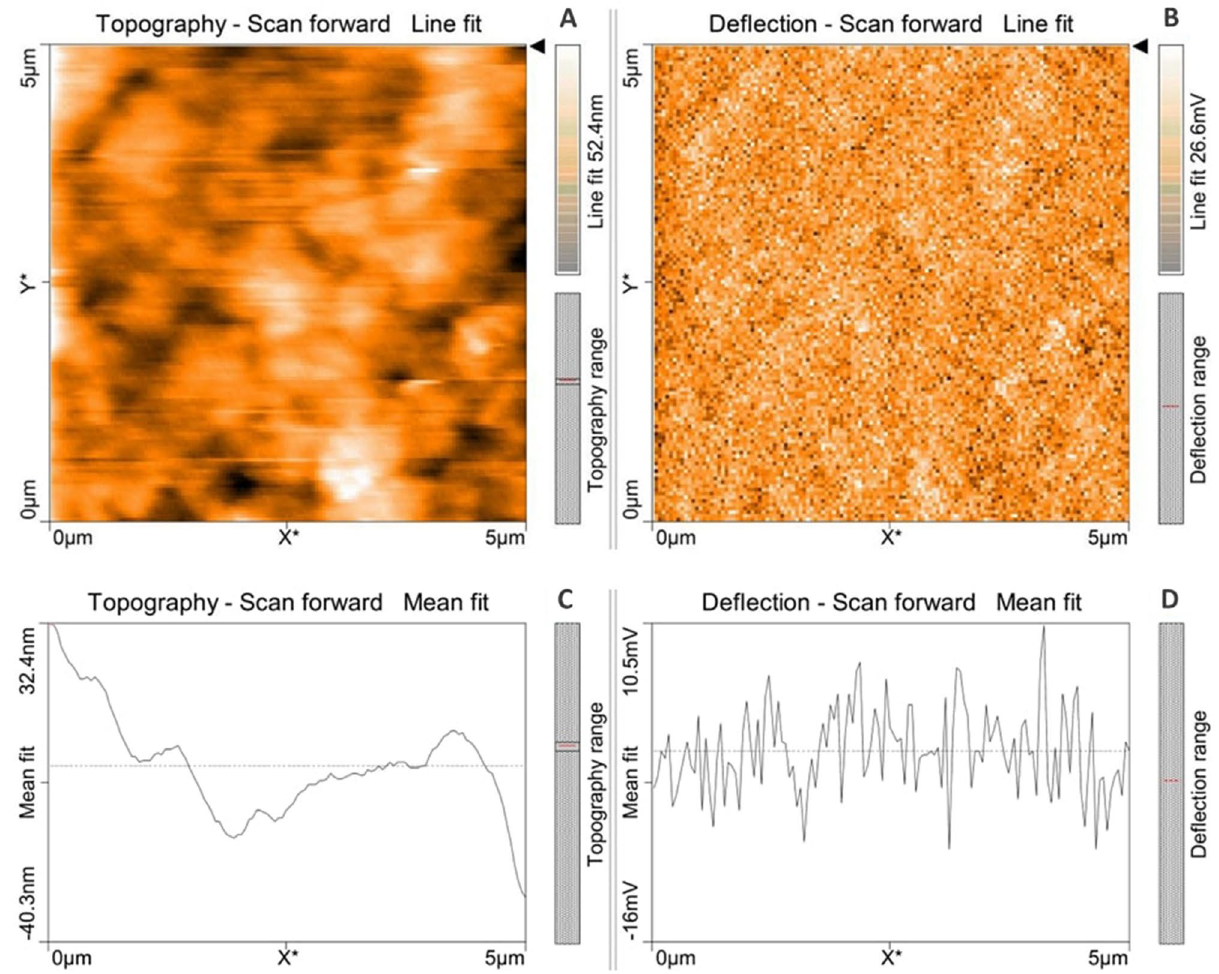
Figure 18. Atomic force microscopic results obtained for control (untreated) LDPE sheet of 5 µm 2 area: ( A ) Topography of the surface (Line fit); ( B ) Voltage deflection (Line fit); ( C ) Topography with mean fit; and ( D ) Voltage deflection with mean